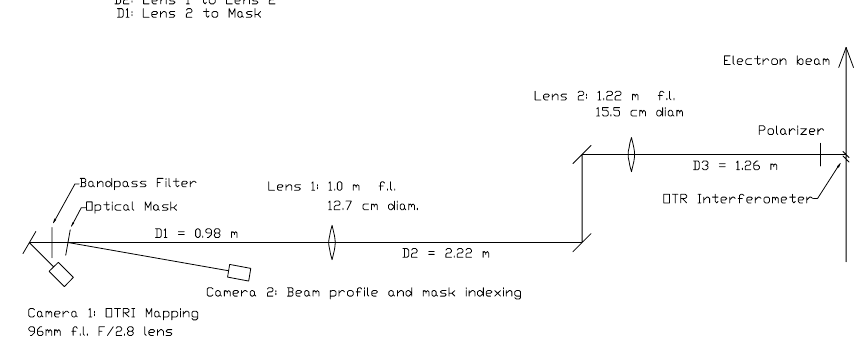
FIG. 2. Masked OTRI experimental